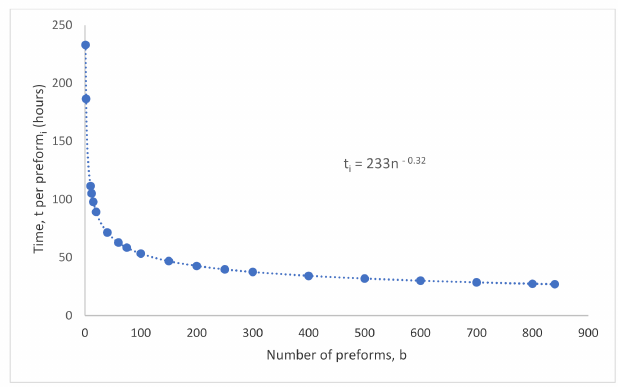
Figure 14. Learning curve for commercial preform